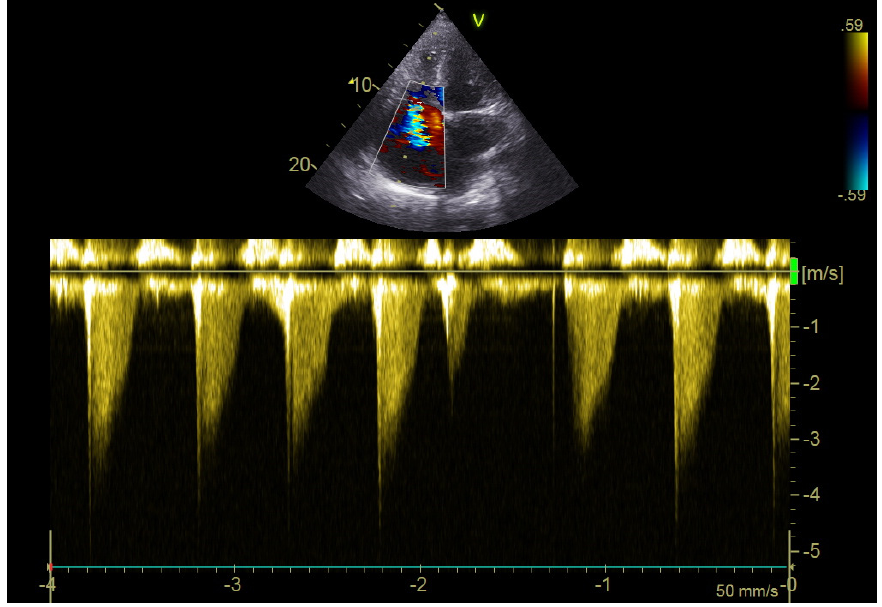
Figure 4. Continuous-Wave (CW) Doppler of tricuspid regurgitation from the 4-chamber